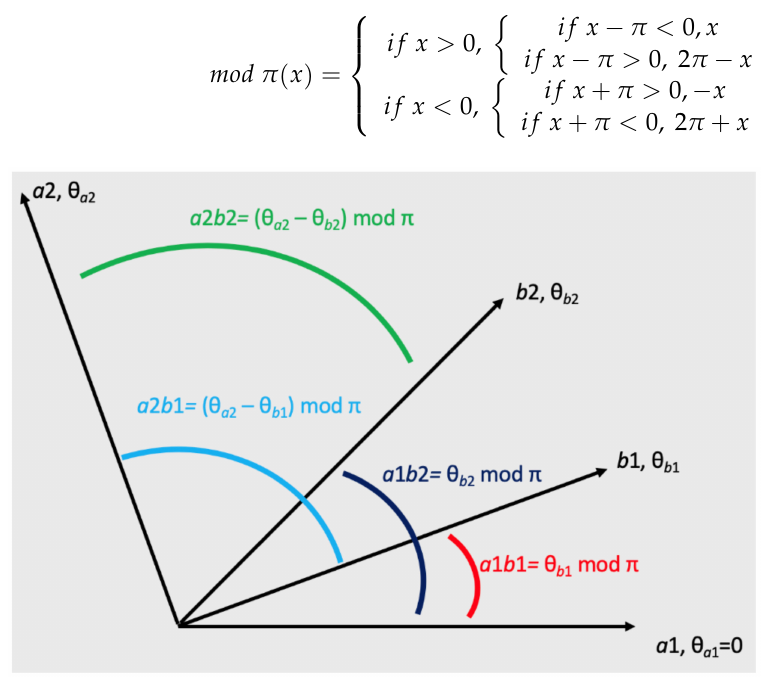
Figure 1. The arrangement of the four measurement